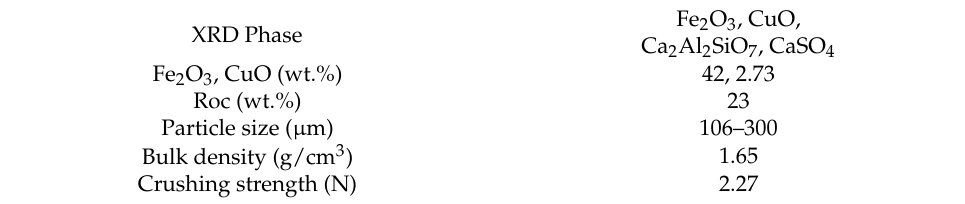
Table 3. Characterizations and properties of the CA70-bonded oxygen